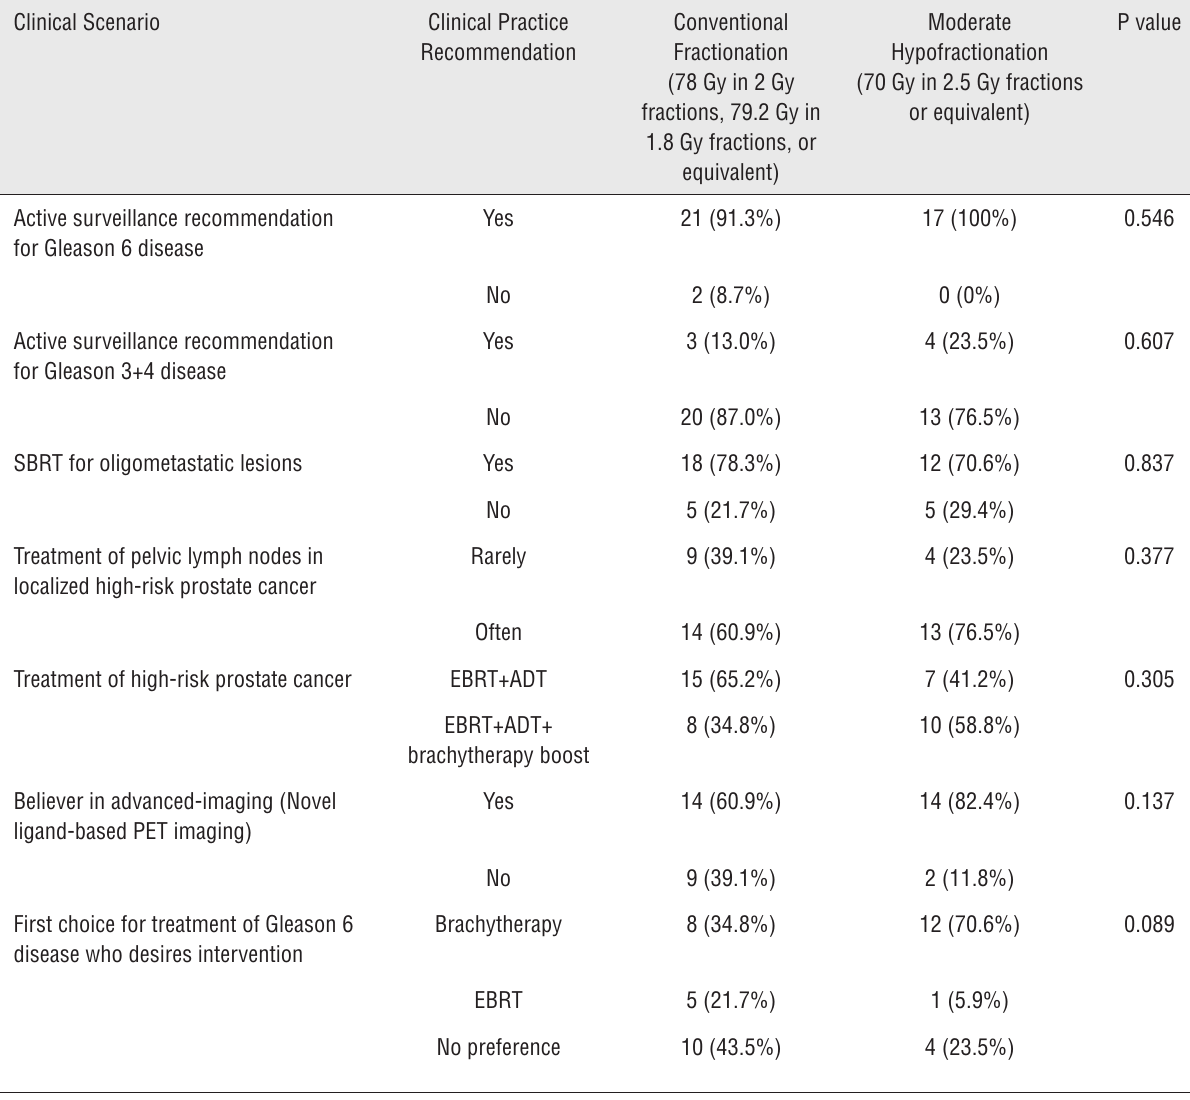
Table 2 - Association between clinical practice recommendations and choice of default dose/fractionation for Gleason 3+4 prostate